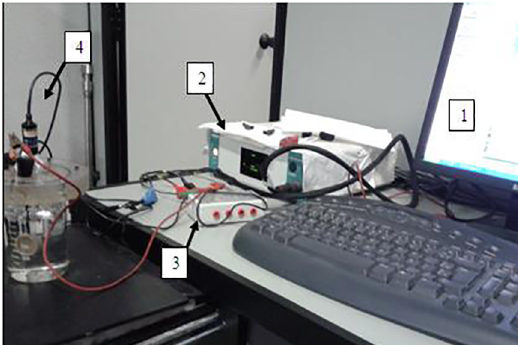
Figure 3. Portable DL-EPR test method. 1- Potentiostat galvanostat µAutolab ® Type III; 2- Saturated calomel electrode; 3- Counter electrode, 4- Fixation of portable electrochemical cell.